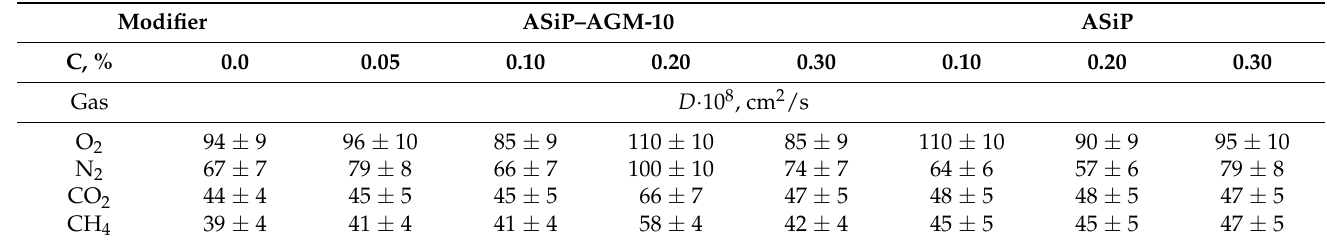
Table 3. Diffusion coefficients (D).